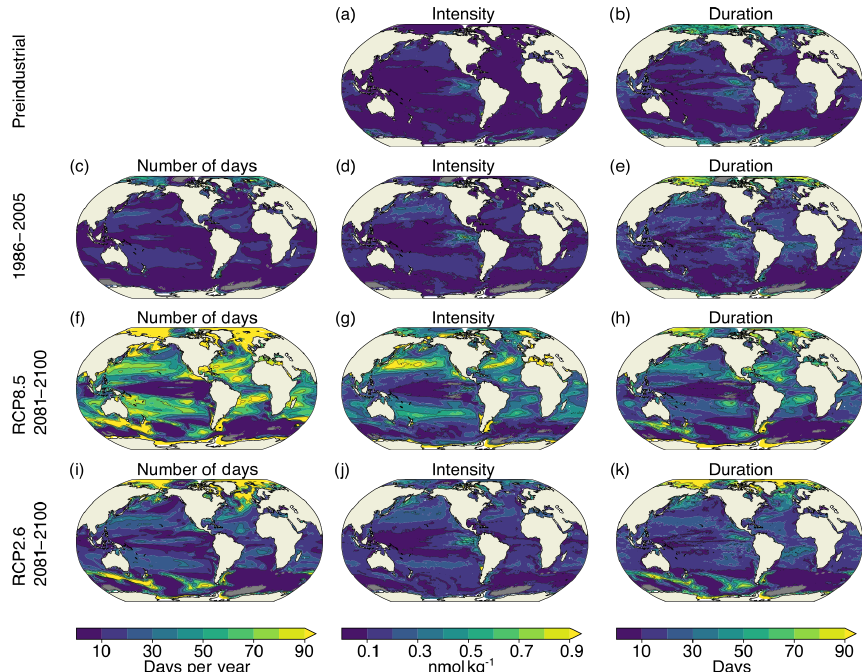
Figure A3. Simulated characteristics of surface [H + ] extreme events for the preindustrial period (a, b) , 1986–2005 ensemble mean (c–e) , RCP8.5 2081–2100 ensemble mean (f–h) , and RCP2.6 2081–2100 ensemble mean (i–k) . The extreme events are defined with respect to shifting baselines. Gray colors represent regions where no ensemble member simulates extremes. The black contours highlight the pattern structures.